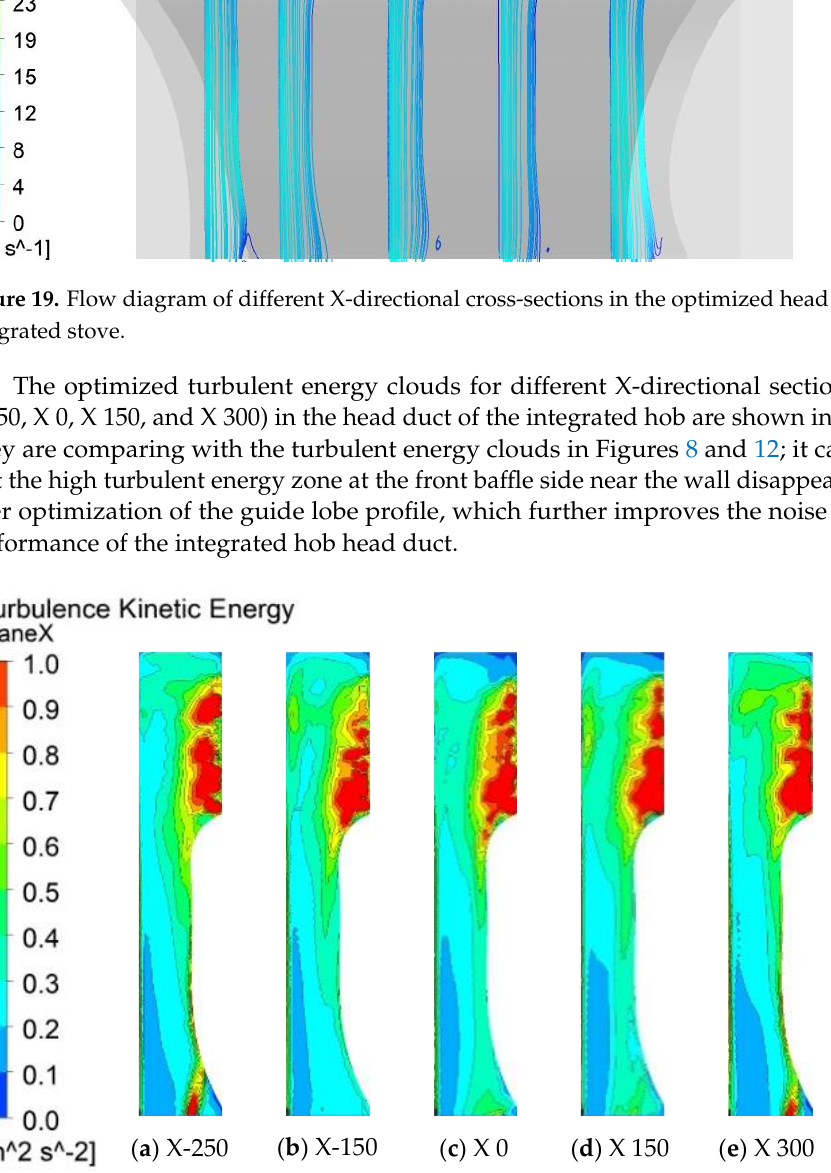
( b ) Side view Figure 18. Guide vane diagram. The flow field characteristics inside the head duct with the optimized guide vane installed were analyzed by numerical simulation method, and the optimized flow line diagrams (X-250, X-150, X 0, X 150, and X 300) on different X-directional sections inside